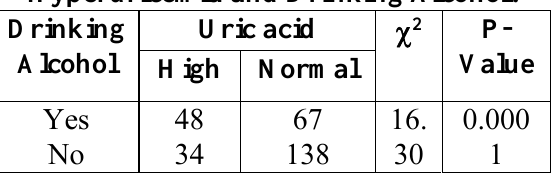
Table No. 4.6 Single Variable Analysis of Hyperuricemia and Drinking